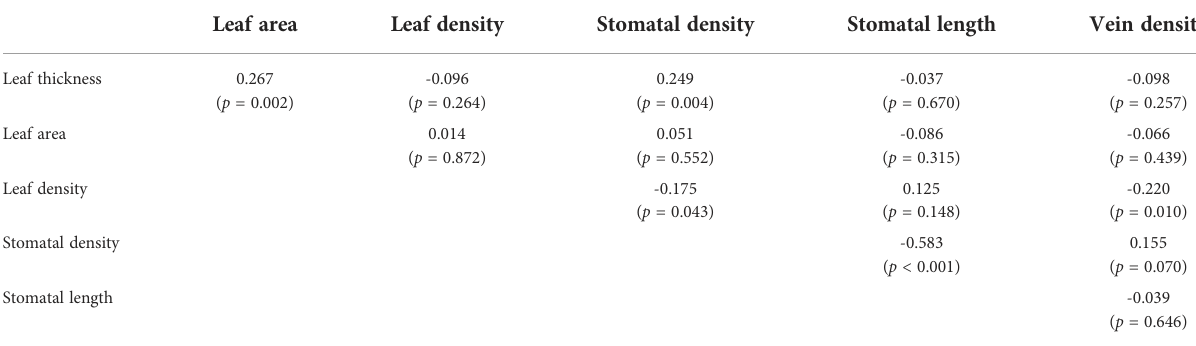
TABLE 1 Estimated within-population correlations between the functional traits, assessed in a common-garden fi eld trial of E. pauci fl ora